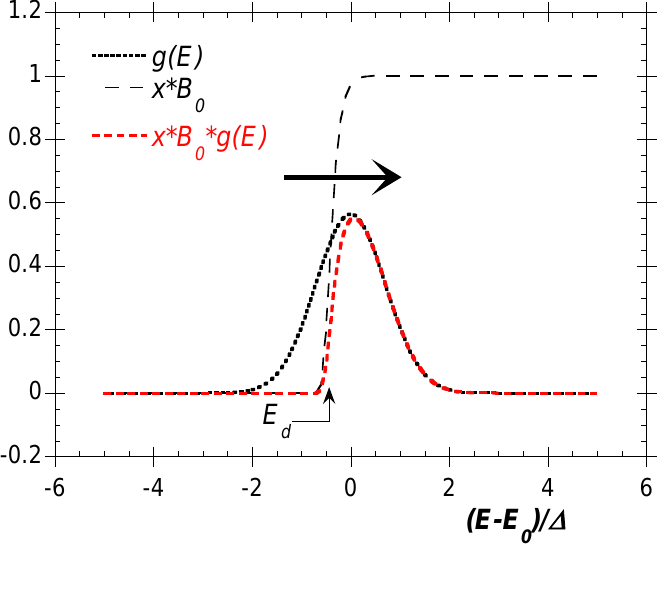
Figure 1. Reaction progresses by erasing B sites, from less stable to the most stable